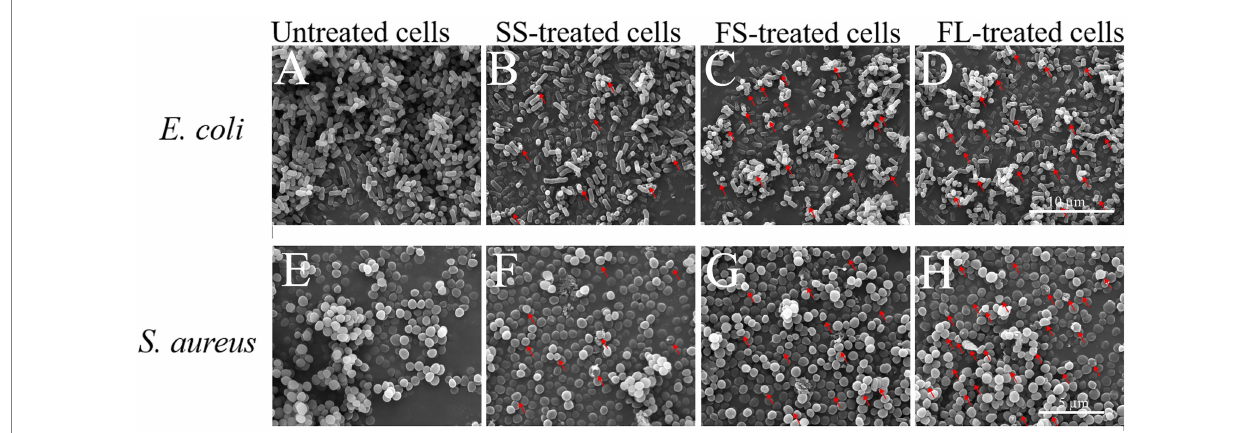
FIGURE 2 Scanning electron micrograph images of E. coli (10,000×, A–D ) and S. aureus (15,000×, E–H ) treated by high hydrostatic pressure (250 MPa/5 min and 450 MPa/5 min, respectively). (A,E) Control. (B,F) SS treatment. (C,G) FS treatment. (D,H) FL treatment. The arrows referred to the damage on the cell